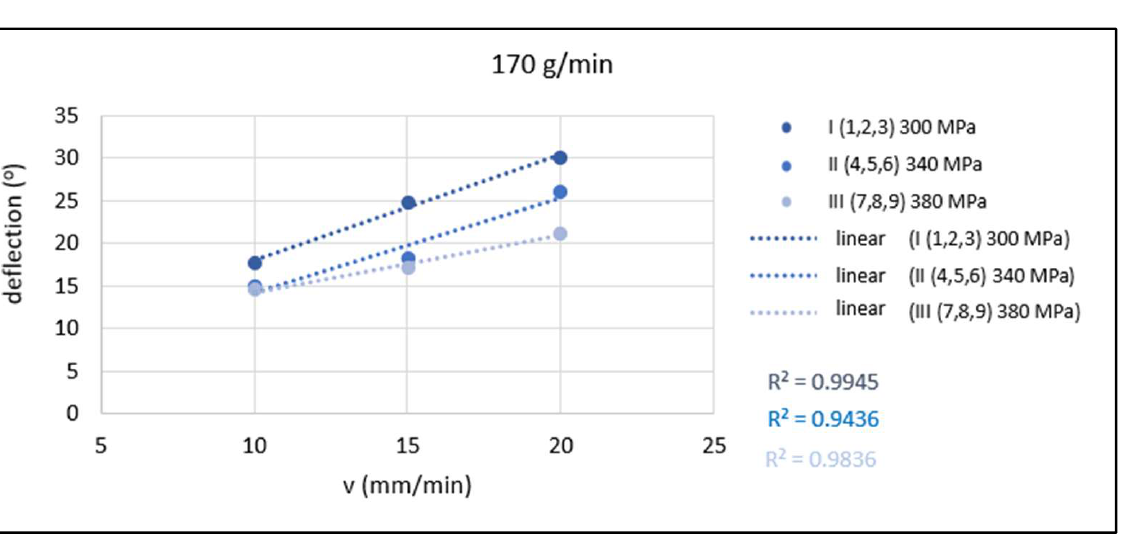
Figure 11. Graphical evaluation of 1-parametric dependencies of Ø = f( v ) for m A = 170, 220 and 270 g/min. 4. Discussion Specifically, the values of technological parameters m A = 170 g/min, p = 300 MPa and v = 20 mm/min (cut I/3) represent the combination for the highest values of the roughness parameters measured ( Ra = 6.95 and Rz = 24.96), whereas Ra values range from 2.27 to 6.95 and Rz range from 16.02 to 24.96. The possibility to reduce the Ra value from 6.95 to 2.27 represents an improvement in roughness of almost 68% (approximately one third of the highest value reached). On the other side, the values of technological parameters m A = 270 g/min, p = 380 MPa and v = 10 mm/min (cut IX/25) represent the combination for the lowest roughness param- eters measured ( Ra = 2.27 and Rz = 16.02). The reduction in the Rz value from 24.96 to 16.02 represents an improvement in roughness of almost 36%.